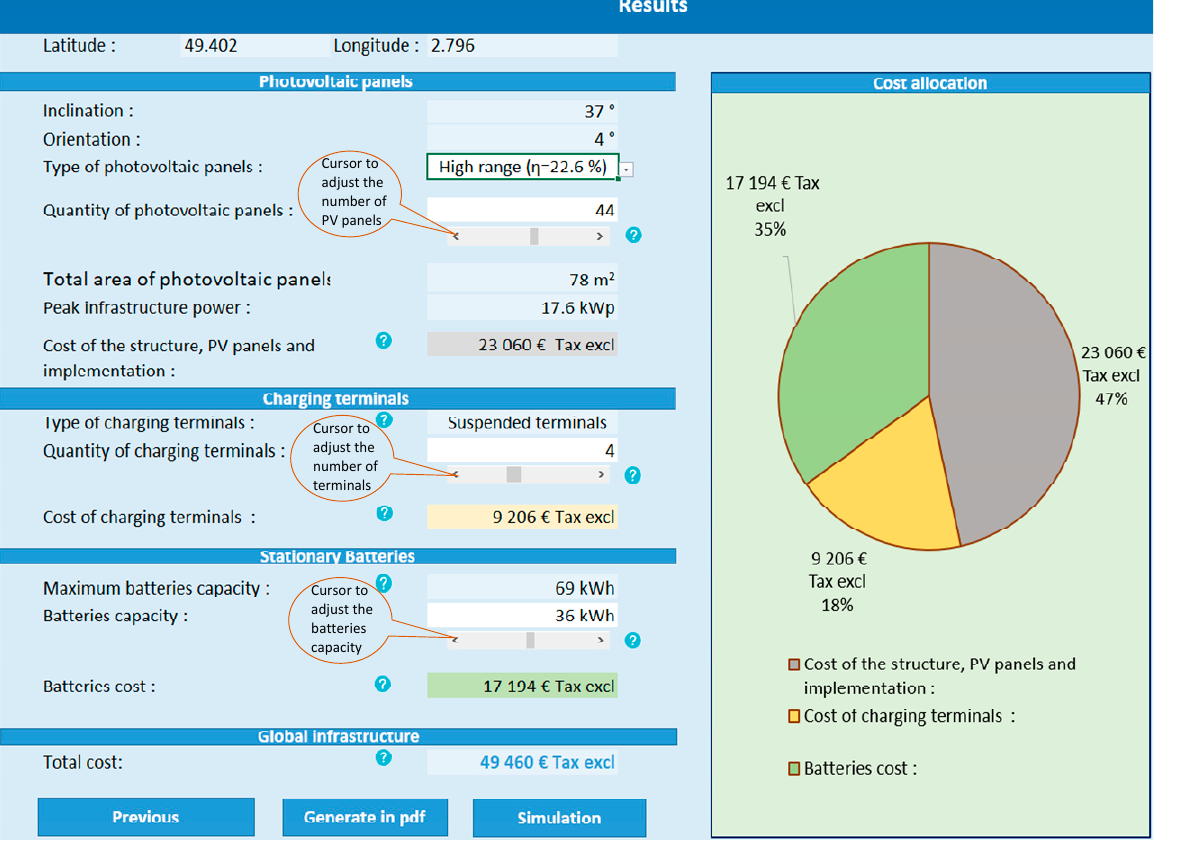
Figure 5. Interface for adjustment of the total PVCS cost.